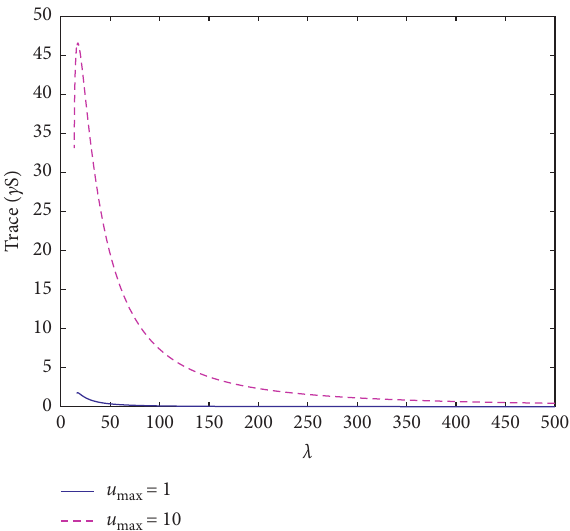
Figure 2: Variation of the trace of the matrix c S with respect to the parameter λ and for two different values of the saturation level: u � 1 and u � 10. Here, for u � 1 (resp. u � 10), we max max max max have adopted δ � 1 (resp. δ � 10). Moreover, in the two cases, we have fixed ρ � 10.